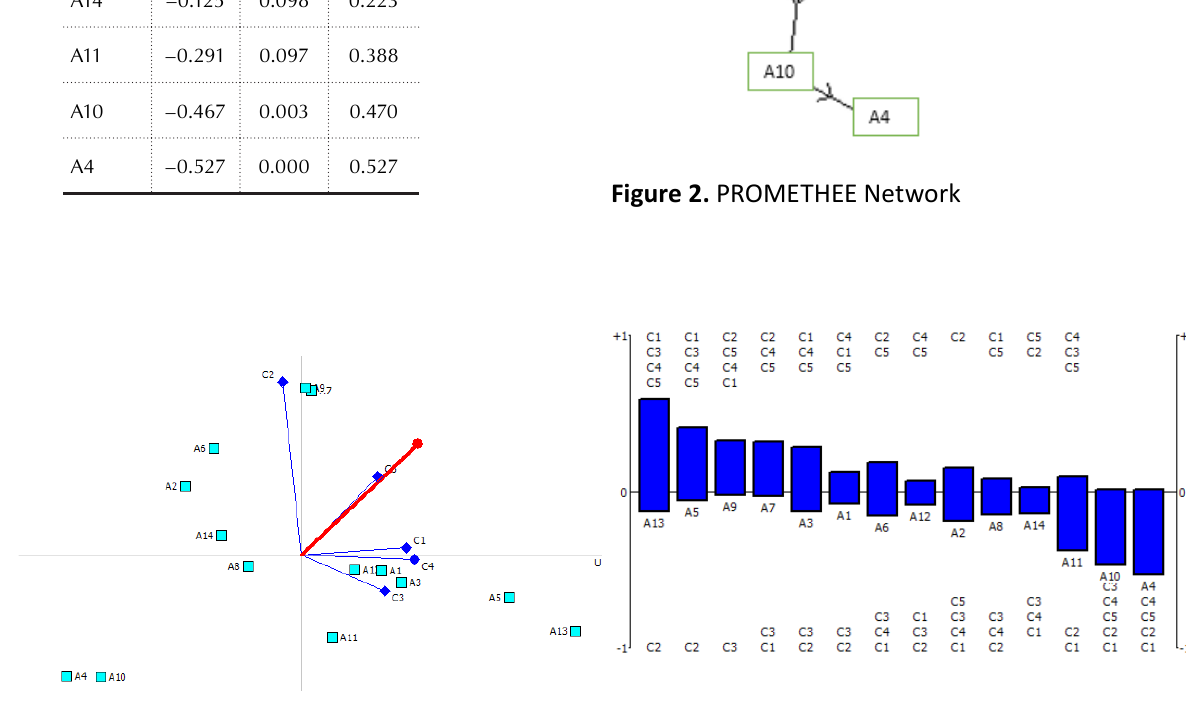
Figure 4. PROMETHEE